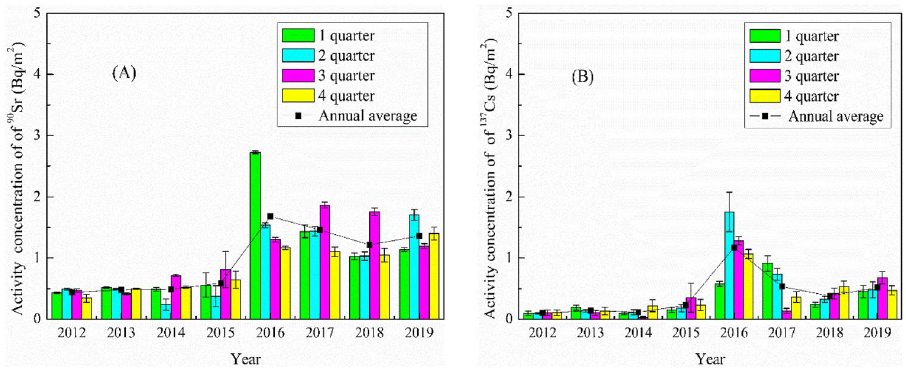
Figure 2. Variation of 90 Sr ( A ) and 137 Cs ( B ) activity concentration in total atmospheric deposition collected around of QNPP during